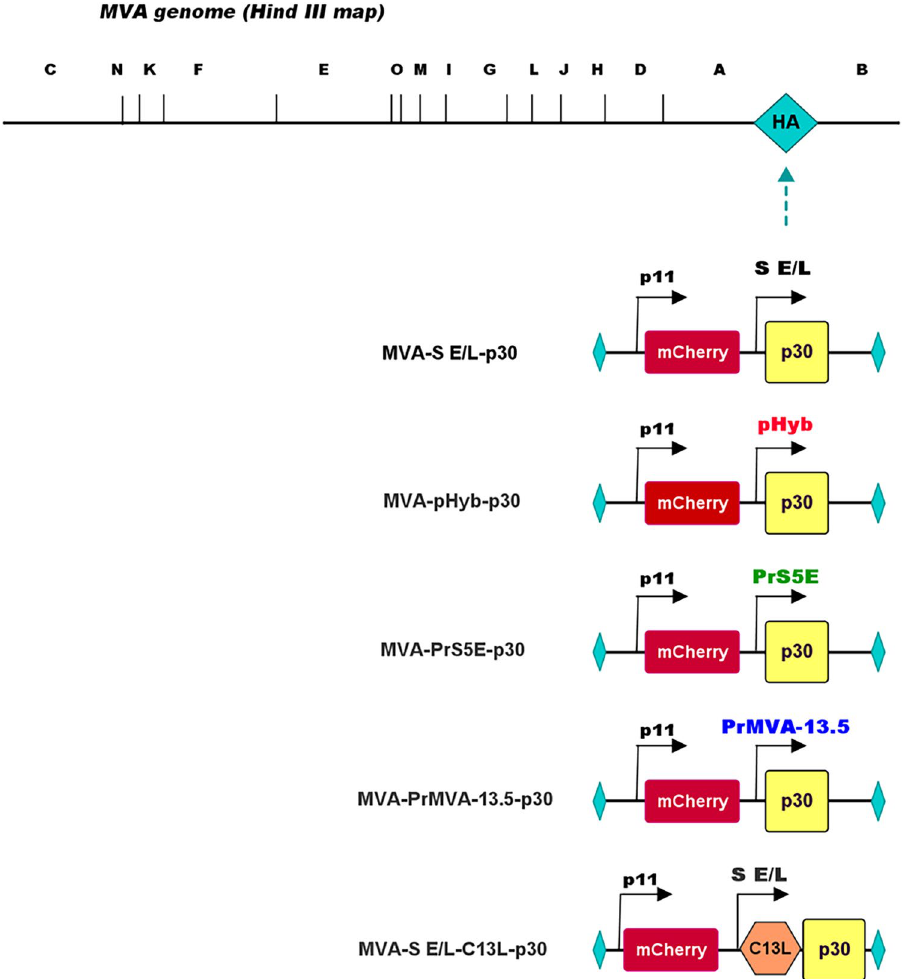
Figure 1. Generation and characterization of MVA-p30 viruses. Diagram of the MVA genome and DNA fragments used for homologous recombination to generate the recombinant MVA viruses. Hind III restriction endonuclease sites within the genome of MVA and the HA gene are indicated. Each expression cassette containing the p30 gene under the control of either the S E/L, pHyb, PrS5E, or PrMVA-13.5L promoters, and the S E/L promoter in frame with the C13L secretory signal are depicted. Also included in each cassette is the mCherry gene under the control of the p11 promoter and flanking regions to the HA gene, where the expression cassettes were inserted into the MVA